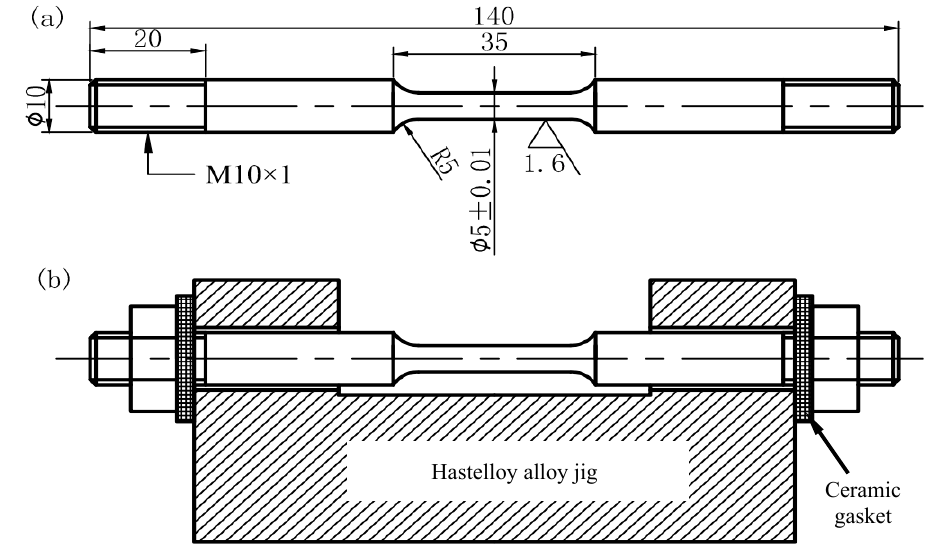
Figure 3. Sizes of ( a ) the specimen and ( b ) the assembling jig used for preloading.